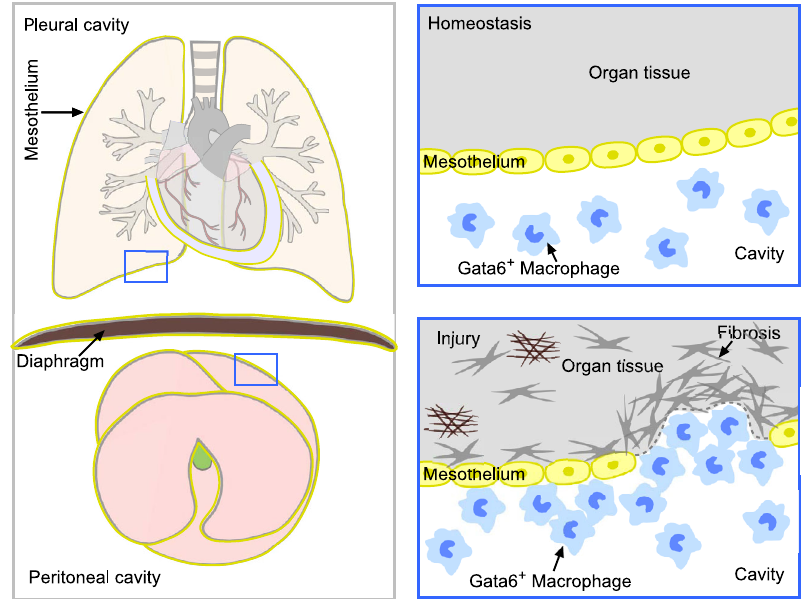
Fig. 8 Pleural and peritoneal cavity macrophages minimally invade visceral organs after injuries. Gata6 + cavity macrophages are located in peritoneal and pleural cavities, which are separated by mesothelium that wraps visceral organs such as lung, and liver. After injuries, cavity macrophages are recruited to the surface of visceral organs, but they do not in fi ltrate into the parenchyma of organs. Nor do they play a functional role in tissue repair and